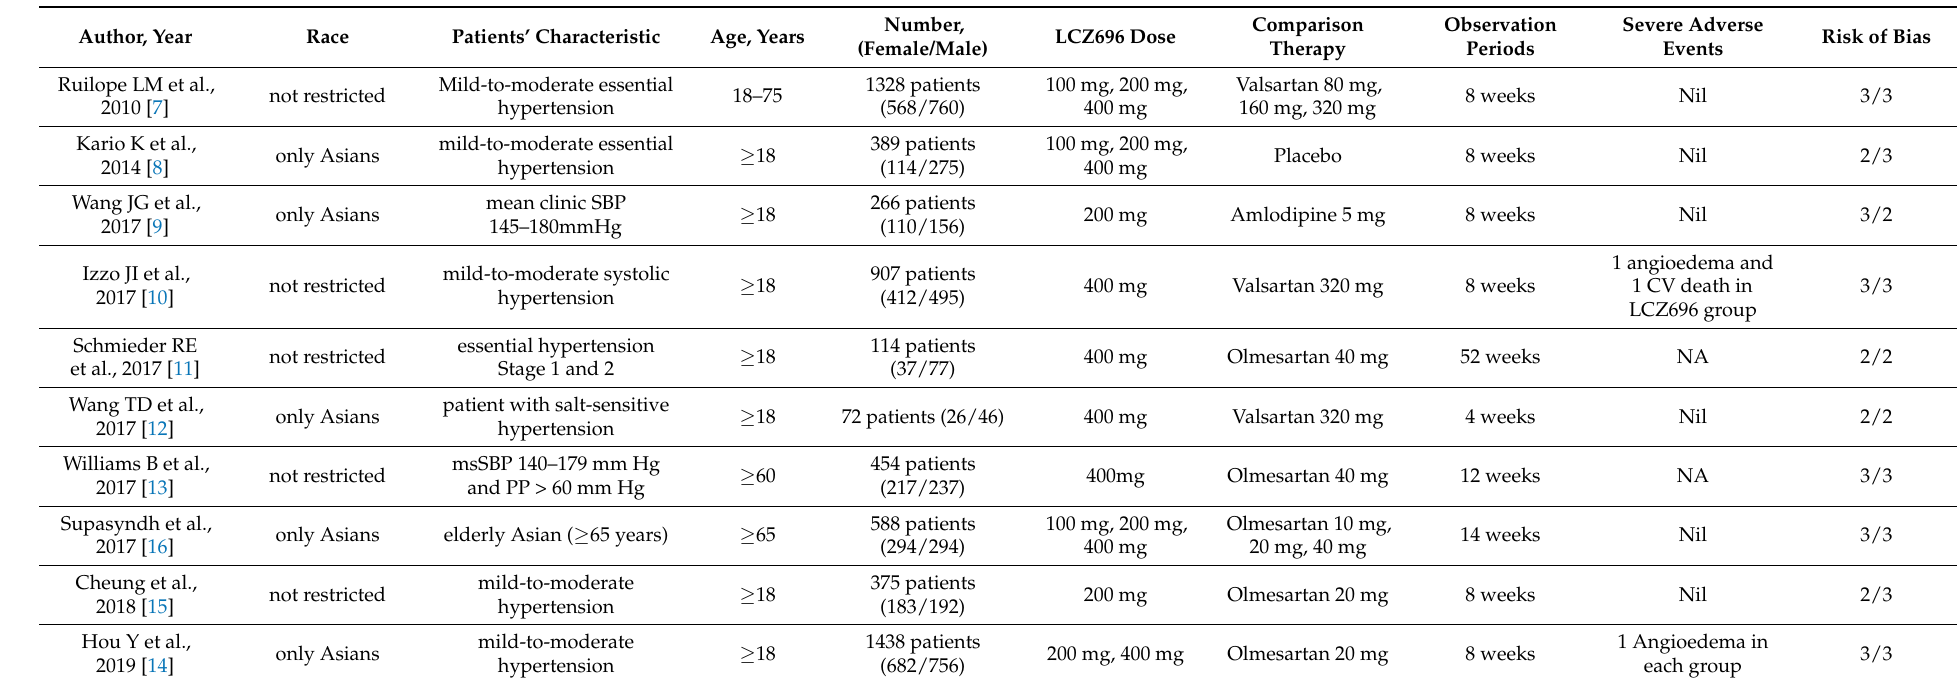
Table 1. Characteristics of the included